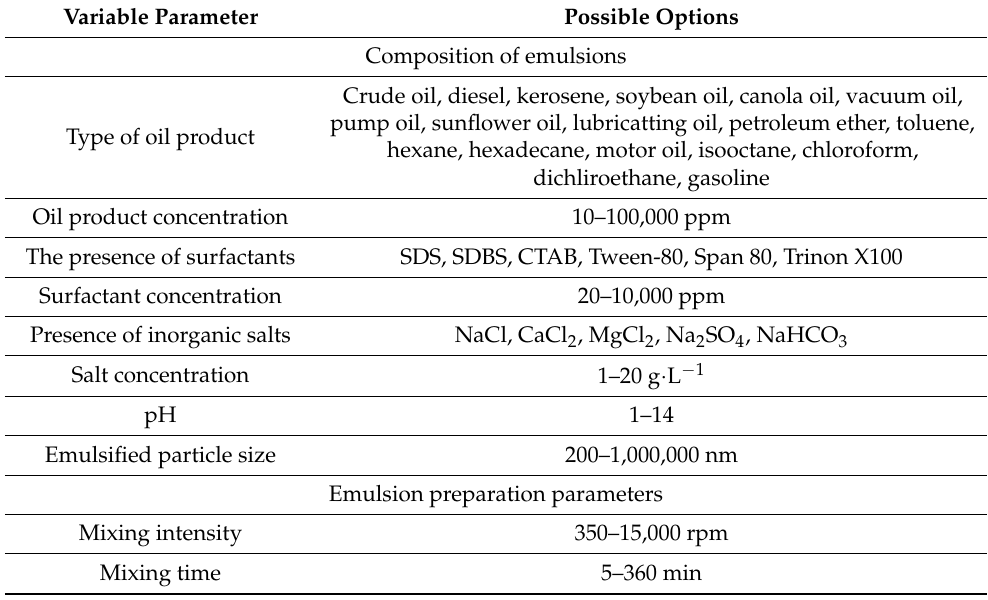
Table 10. The composition of oil-water emulsions and methods for their